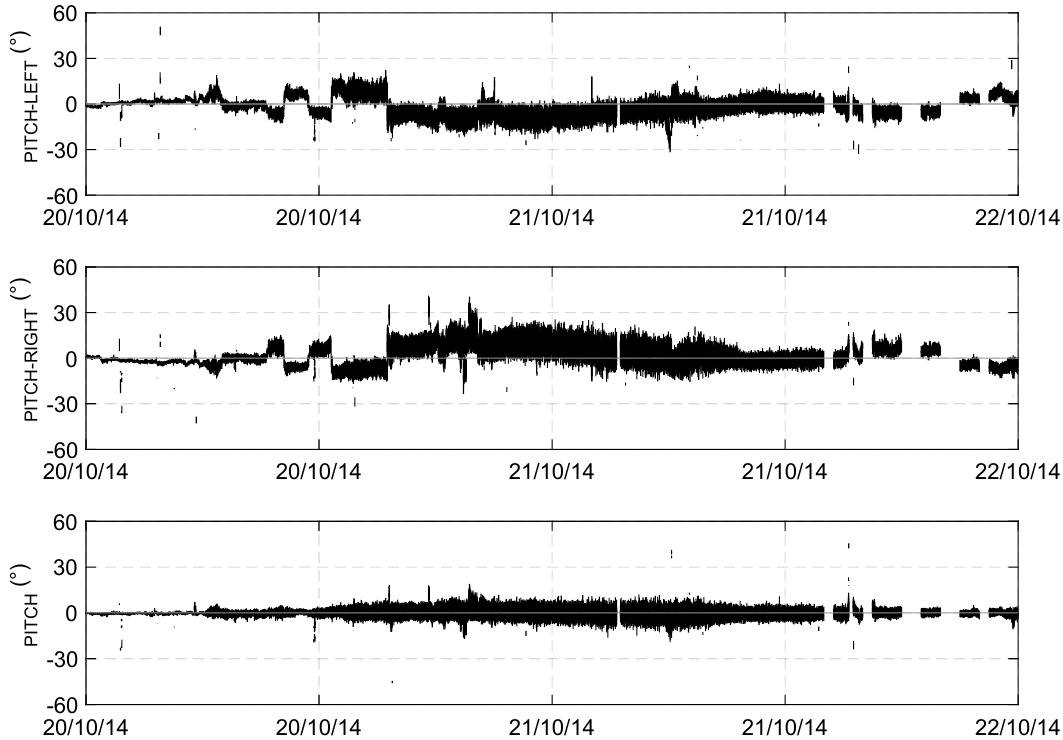
Figure 5. Time series of the angle obtained by using the bow–stern-left GPS couple ( Top ); and the same quantity as obtained by using the bow–stern-right GPS couple ( Middle ) over a time window of four days. ( Bottom ) Time series of the mean signal (pitch) obtained from the two couples bow–stern right and the bow–stern left over a time window of four